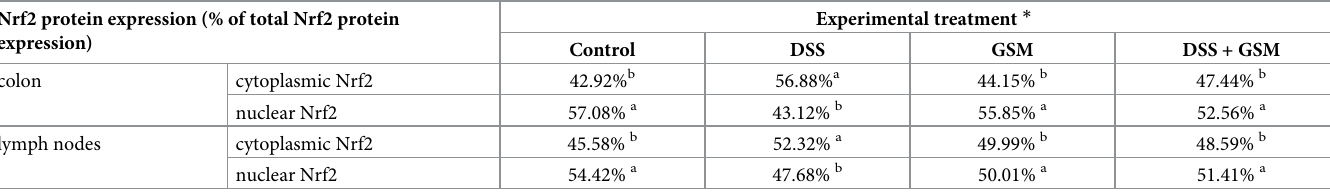
Table 3. Expression of Nrf2 protein in cytoplasmic and nuclear lysates of colon and mesenteric lymph nodes under DSS and GSM action. Nrf2 protein expression (% of total Nrf2 protein